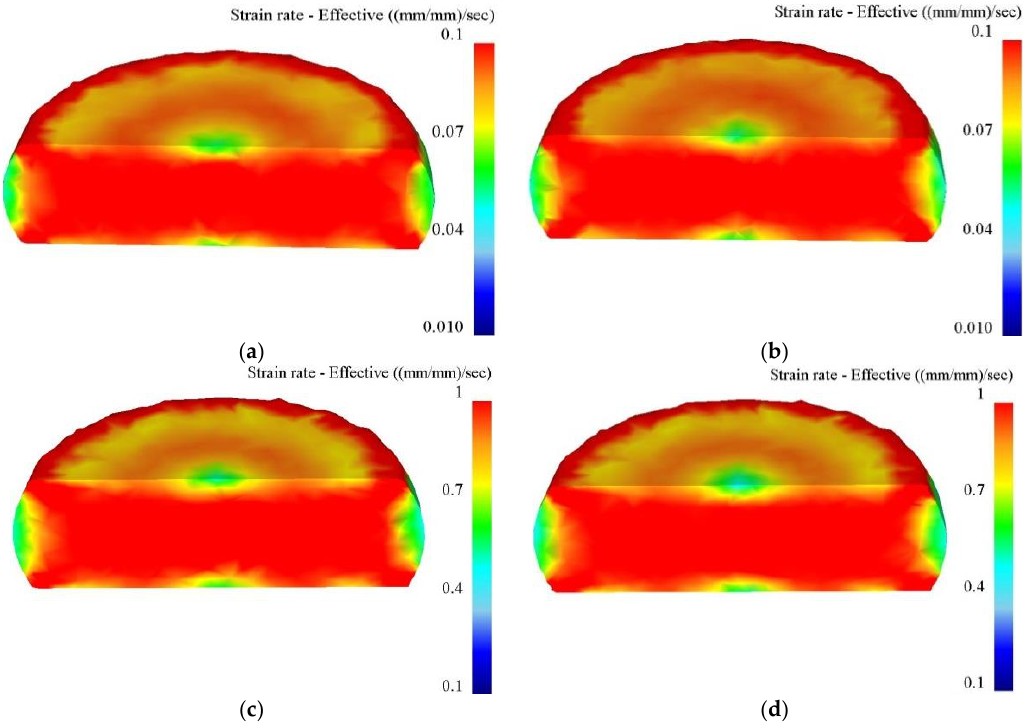
Figure 13. The effective strain rate distributions under the deformation conditions of ( a ) 1153 K and 0.1 s −1 ; ( b ) 1303 K and 0.1 s −1 ; ( c ) 1153 K and 1 s −1 and ( d ) 1253 K and 1 s −1 .